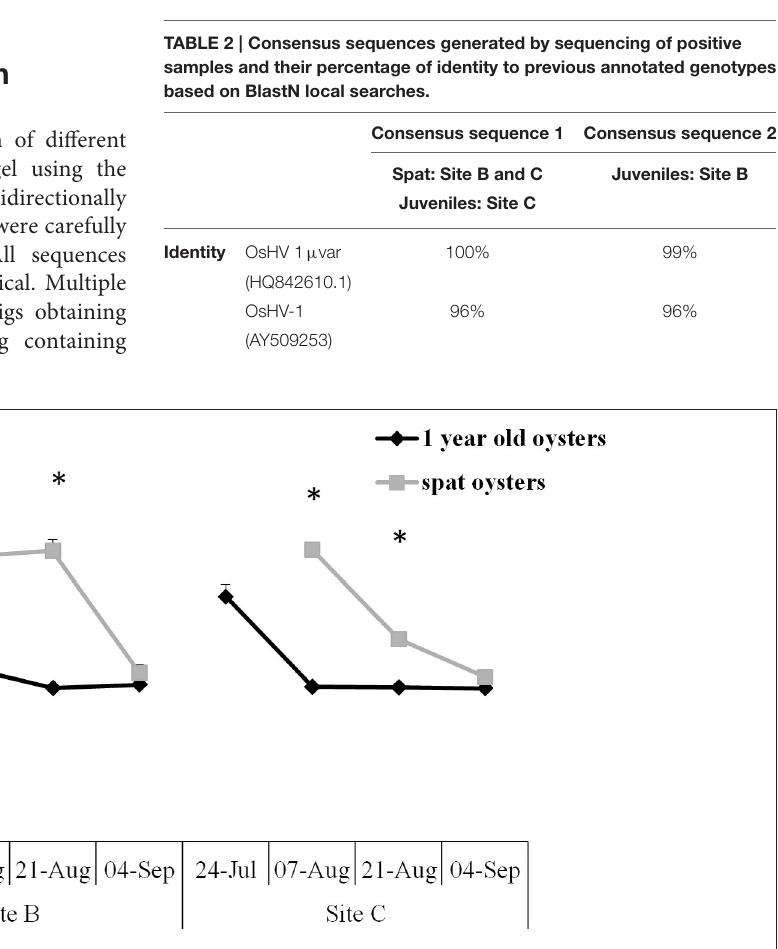
FIGURE 5 | Virus DNA quantification by real-time PCR in juveniles and spat from Site B and Site C at different sampling times. Significant differences between oyster stages are indicated with asterisks ( n = 6, p ≤ 0.05).